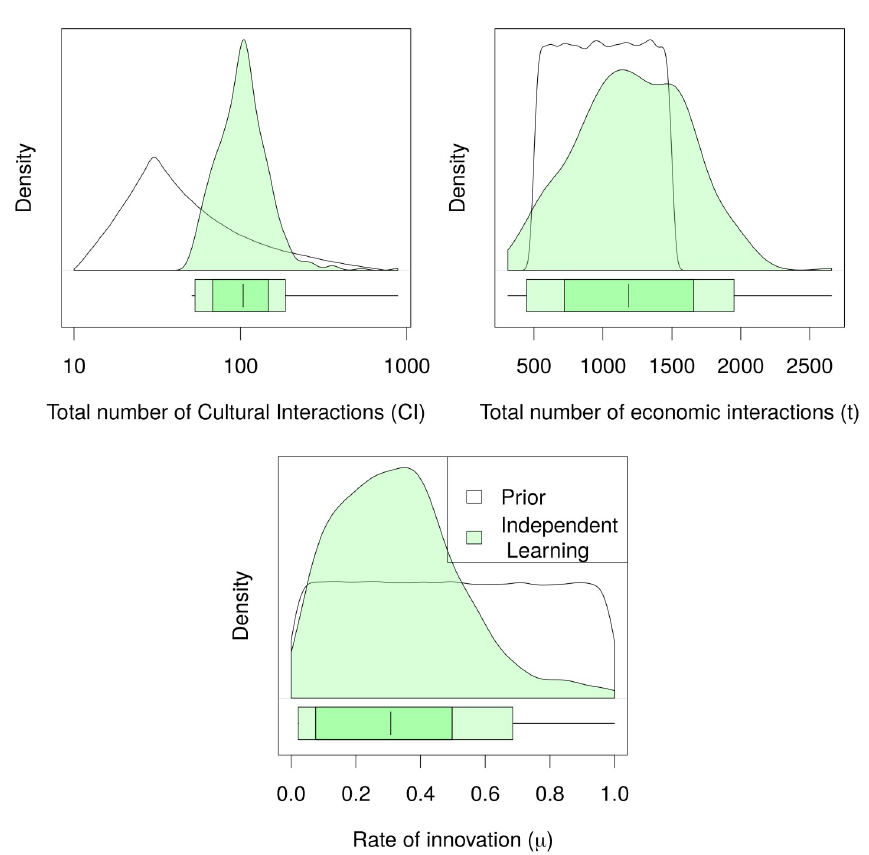
Fig 6. Posterior distribution and high density regions for the model of independent learning. Marginal posterior distributions of the independent learning Model’s parameters. The boxplots at the bottom of each graph shows the 75% HDR (darker green) and the 95% HDR (lighter green). The vertical line indicates the mode of the distribution.